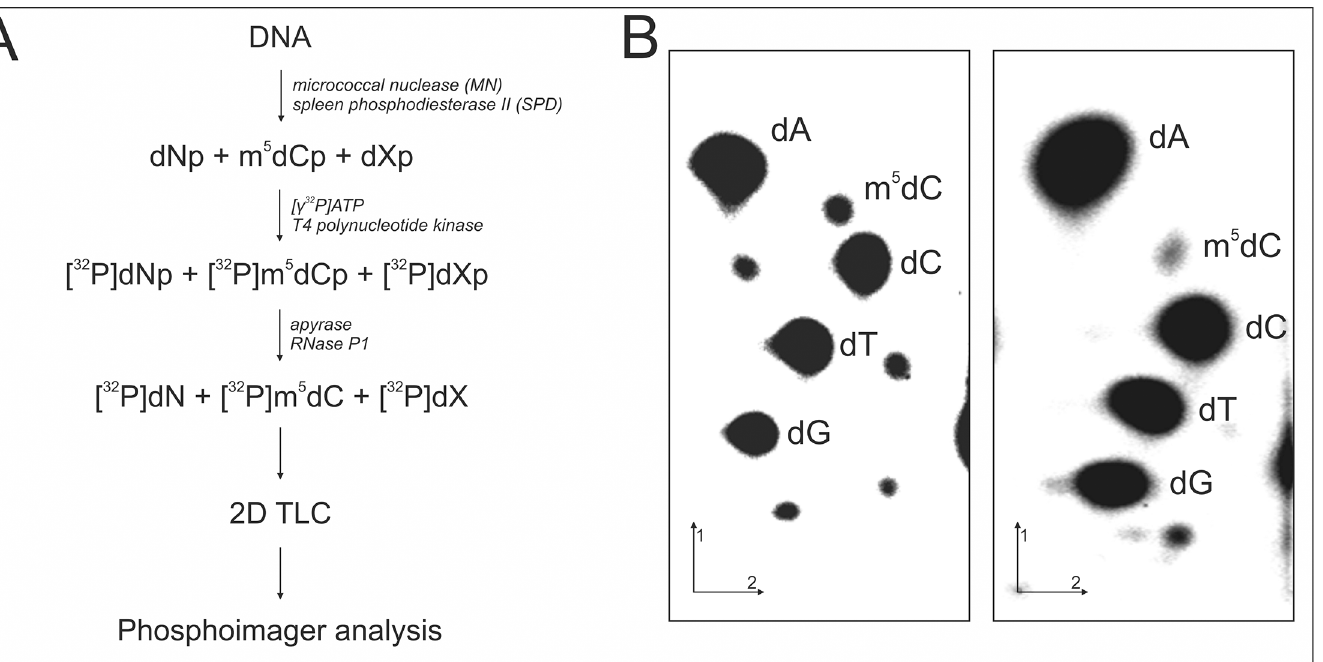
Fig 2. Analysis of m 5 C in DNA. A. Flow chart of the analysis of m 5 C in genomic DNA. Isolated DNA was hydrolyzed to 3 ’ mononucleotides (A — adenosine, G — guanosine, C — cytidine, T – thymidyne and X – other modifications). Furthermore they were labelled with [ γ - 32 P], dephosphorylated of 3 ’ phosphate and separated with TLC in two dimensions. The chromatogram was evaluated with phosphoimager. B. Two dimensional cellulose thin layer chromatography (TLC) analysis of [5 ’ - 32 P] labelled deoxynucleotides obtained by enzymatic hydrolysis of DNA from different types of cells. Pure DNA was isolated from non treated HeLa cells (left) and treated with TMZ (right) for 48